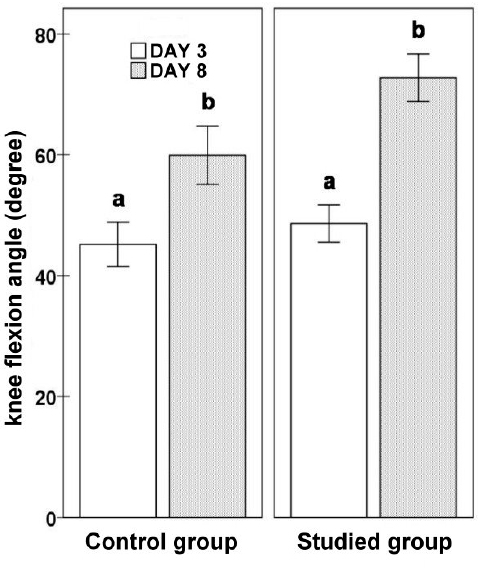
Figure 6. Evaluation of the knee joint flexion angles in the treatment and clinical control groups.